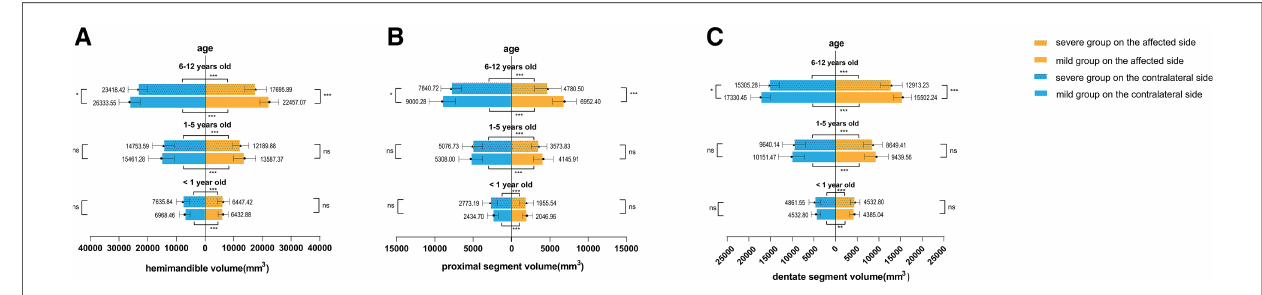
FIGURE 3 Volumetric analysis. ( A ) Hemimandible volume, ( B ) proximal segment volume, and ( C ) dentate segment volume were compared between different severities and sides. * P <0.05, ** P <0.01, *** P <0.001, ns, no signi fi